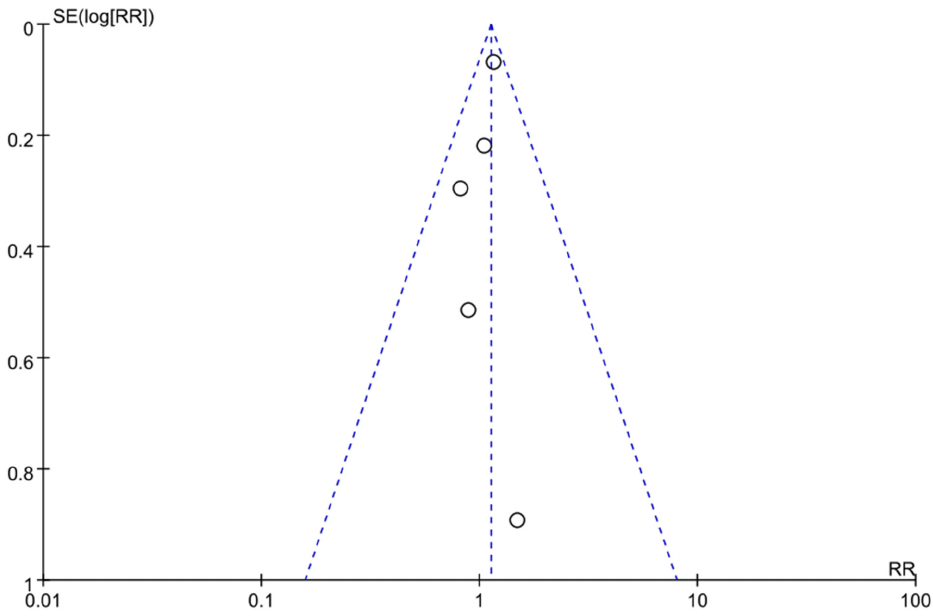
Figure 3. The funnel plot of current studies. The circle presents the risk ratio and standard error (SE) of the log RR of each